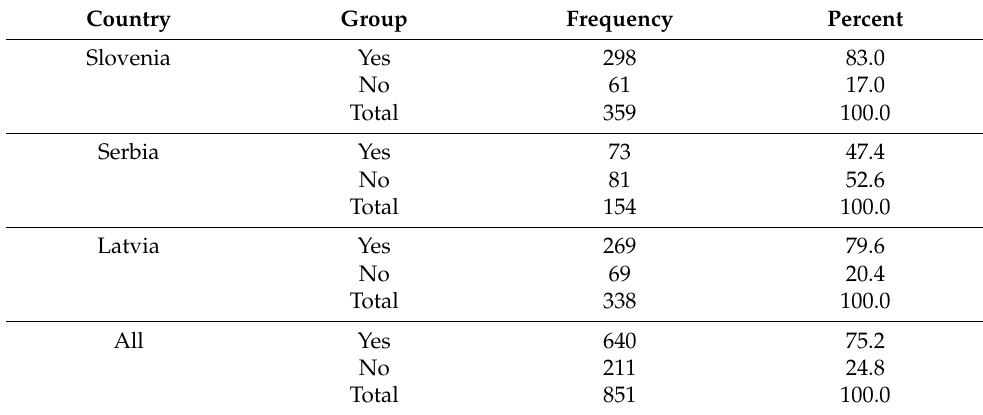
Table A13. Owner or co-owner of the